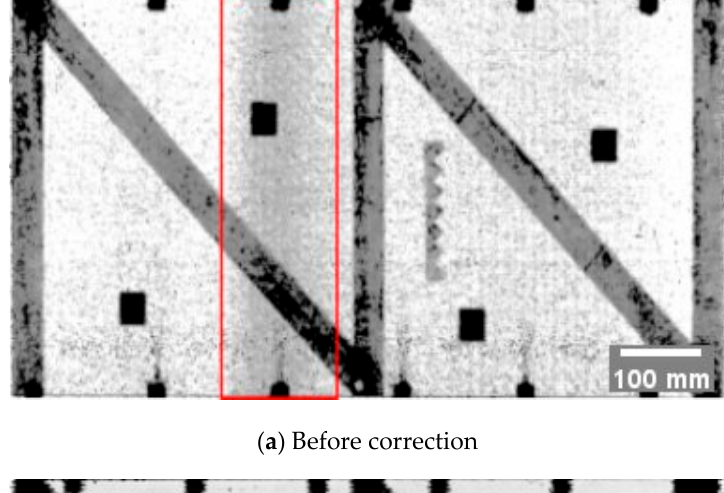
Figure 11. Image after pitch and yaw correction.